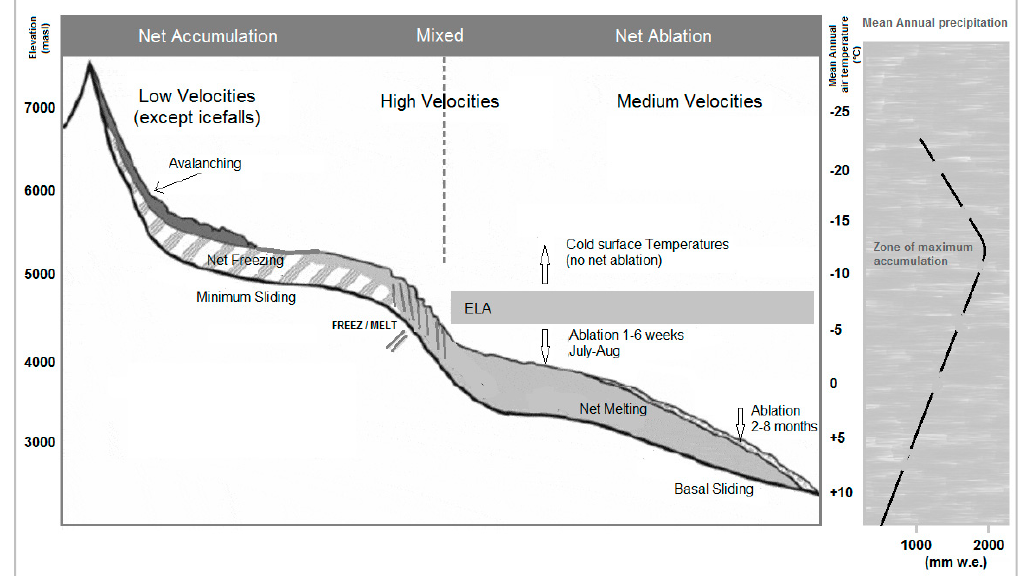
Figure A2. Vertical meteorological and cryspheric regimes in the UIB (modified from Hewitt 2007).